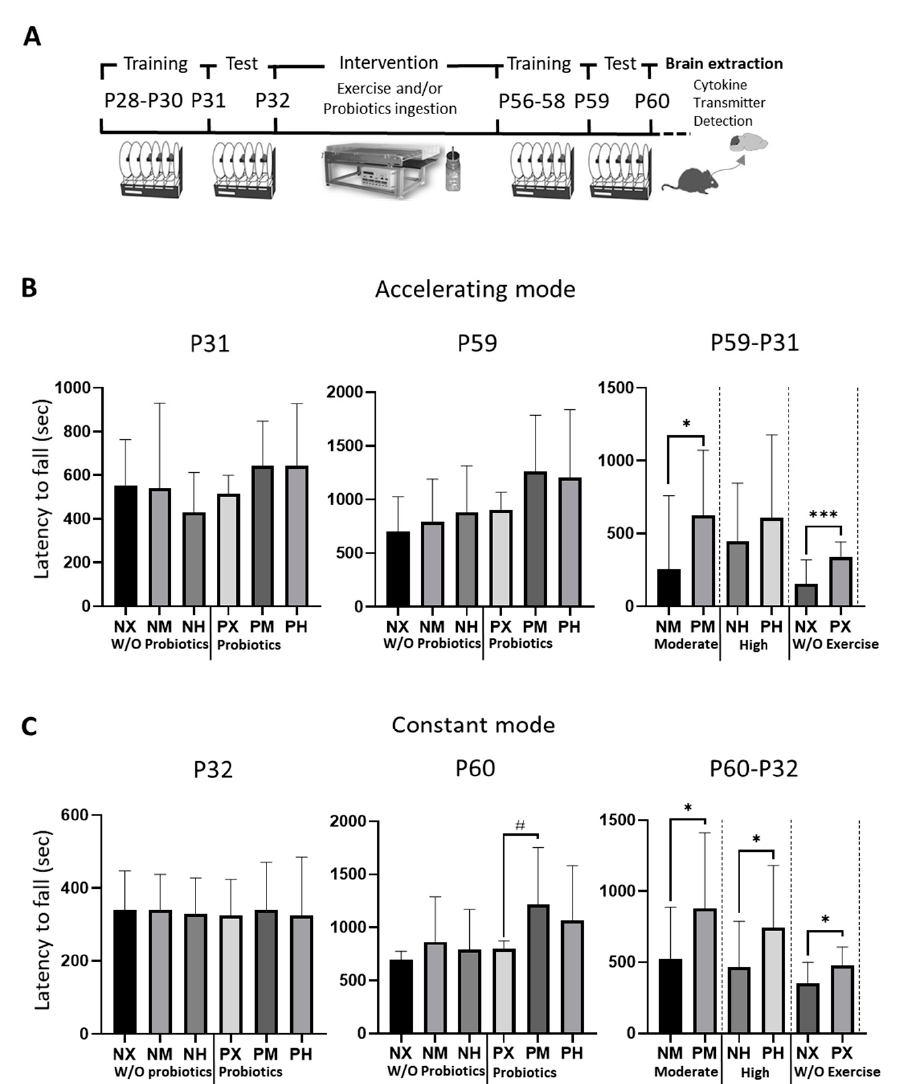
Figure 1. Effect of exercise and probiotics ingestion on motor function. Motor function is enhanced by probiotic ingestion. ( A ) Experimental timeline and schematic illustration. ( B ) Summary bar graphs showing latency to fall during test sessions of rotarod at accelerating mode. ( C ) Summary bar graphs showing latency to fall during test sessions of rotarod in constant mode. Values are presented as mean ± SD; #; p < 0.05. Significant difference was indicated by One-way ANOVA. *; p < 0.05, ***; p < 0.001. Significant difference was indicated by independent t -test. N, no probiotics; P, probiotics; M, moderate-intensity exercise; H, high-intensity exercise; X, no exercise.